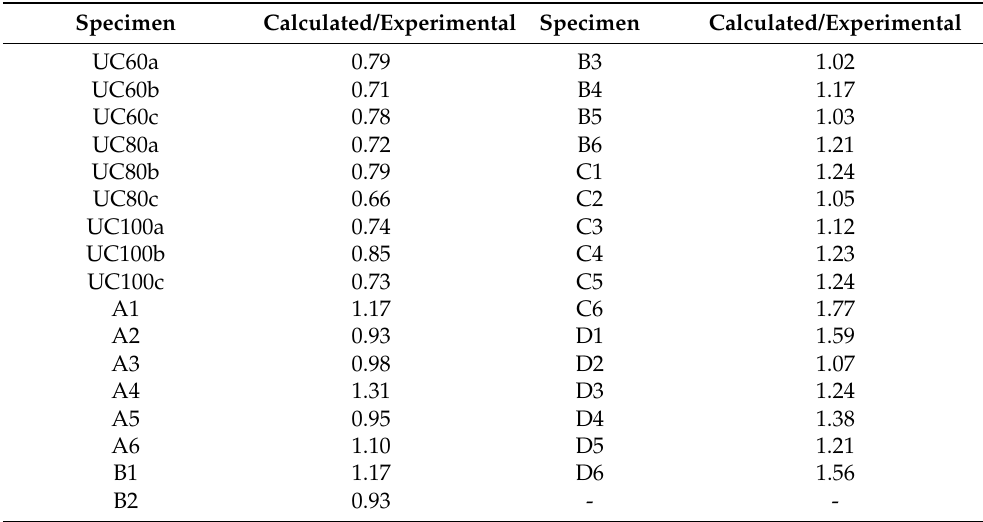
Table 2. Comparison of calculated values and experimental values based on ACI